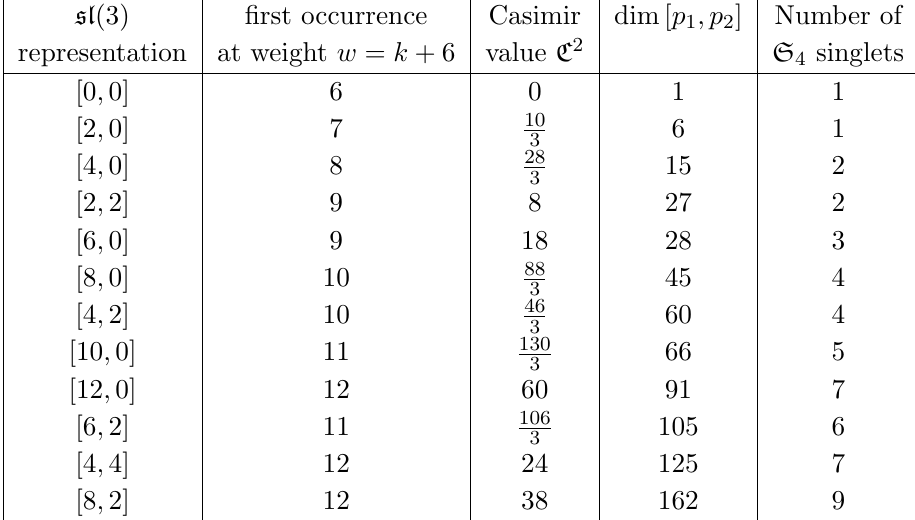
Table 1 . Number of S 4 singlets in various representations of sl (3) together with their Casimir eigenvalues and the weight of the tetrahedral modular graph function for which they arise (cid:12)rst. The list is ordered by the dimension of the representation and complete up to dimension